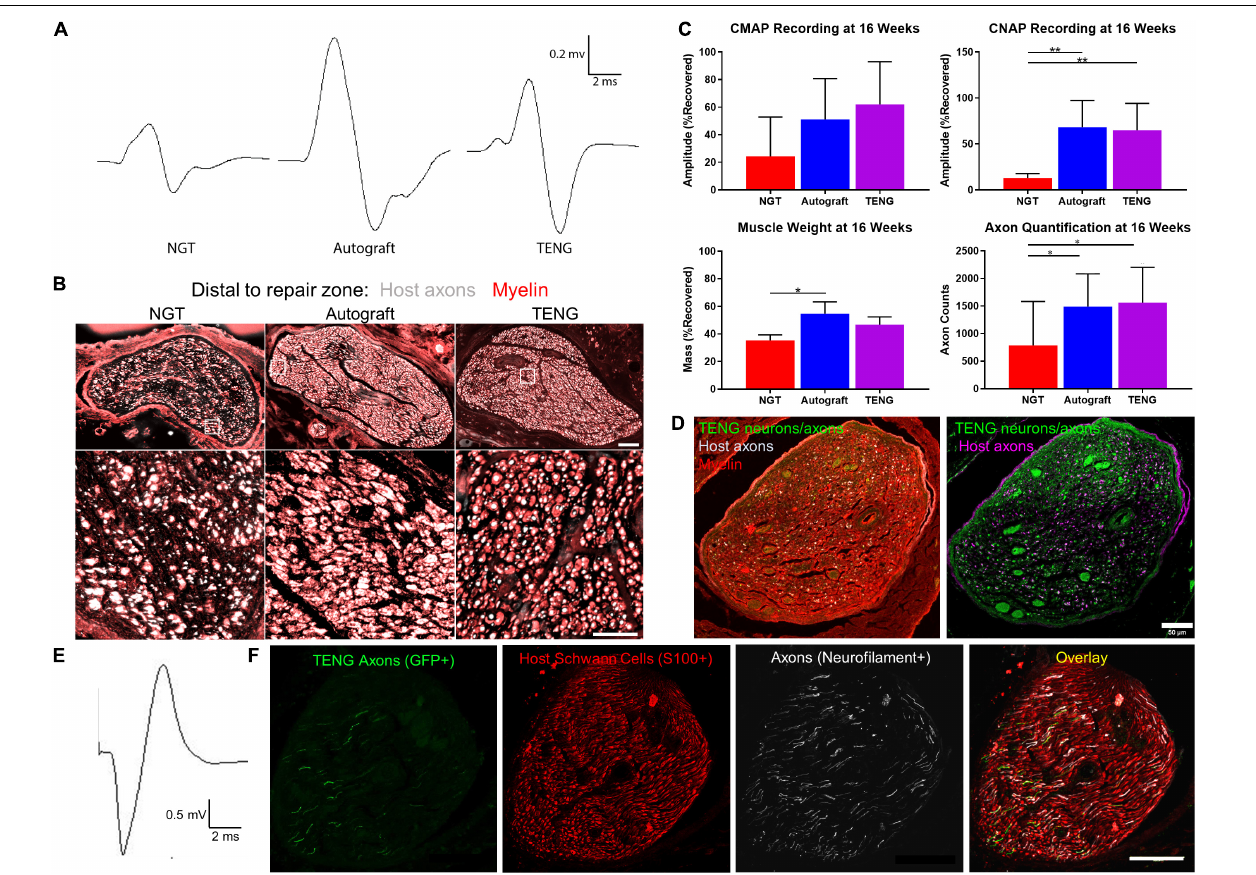
FIGURE 6 | TENGs Facilitate Functional Recovery. (A–C) Functional recovery and structural regeneration at 16 weeks following repair of 1 cm nerve lesions using NGTs, reverse autografts, or TENGs. (A) Representative CMAP traces. (B) Representative nerve morphometry showing nerve cross sections (5 mm distal to repair zone) labeled for axons (red) and myelin (purple). Scale bar (top): 100 µ m; scale bar (bottom): 50 µ m. (C) Plots of mean recovery levels for CMAP, CNAP, muscle weight, and axon density (mean ± standard deviation; * p < 0.05 and ** p < 0.01 versus NGT). (D–F) Proof-of-concept data showing structural and functional regeneration at 12 weeks following repair of 2 cm nerve lesions using TENGs. (D) Chronic nerve morphometry showing representative nerve cross sections (5 mm distal to repair zone) labeled for axons (purple) and myelin (red), also showing TENG neurons and axons (green). Scale bar: 50 µ m. (E) Example CNAP across a 2 cm nerve segment repaired using a TENG. (F) Oblique nerve cross section (5 mm distal to repair zone) showing the architecture of numerous TENG axons (GFP+, green) interacting with host SCs (S100+, red) and growing along other axons (NF+, purple). Scale bar: 100 µ m. (A,E) Electrophysiological traces were averaged over a train of 5 pulses with 1 s intervals between each pulse, with band pass filtering from 10 to 10,000 Hz for CMAP and 10–2000 Hz for